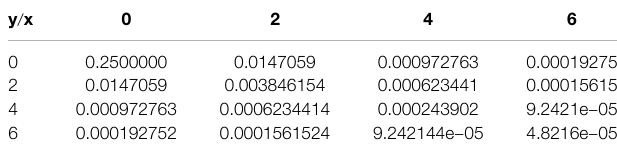
TABLE 8 | Positive surface data from function F 3 ( x , y )